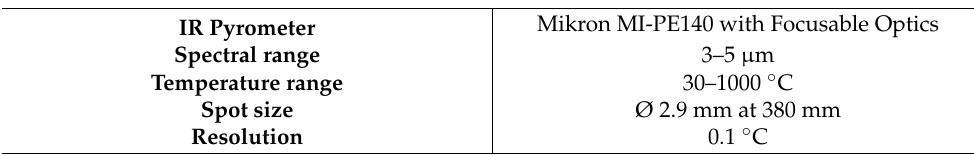
Table 3. IR pyrometer specification.